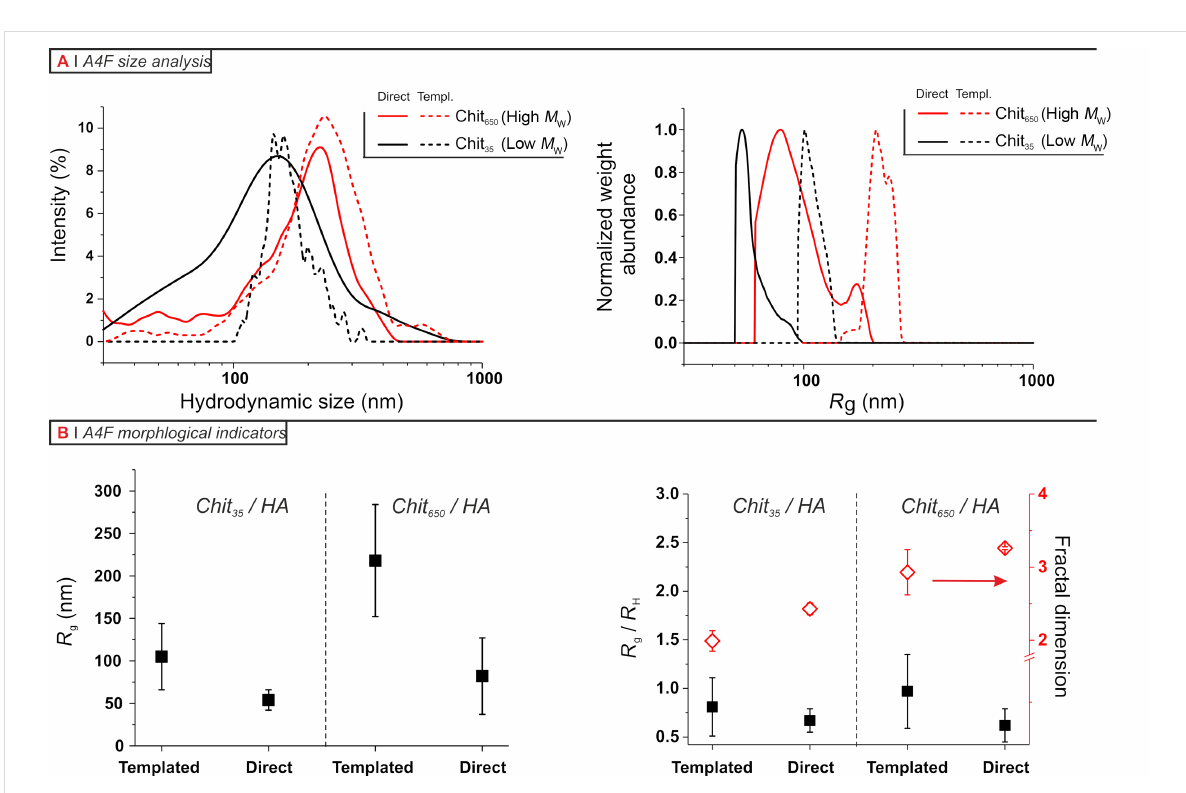
Figure 3: A) Asymmetric-flow field flow fractionation (AF4) characterization of nanoparticles (see also Supporting Information File 1, Figure S3 for ex- amples of AF4 elugrams). Left: hydrodynamic size distributions from in-line DLS. Right: R g distributions from in-line SLS. B) Morphological indicators obtained from AF4 analysis. Left: Weight-average R g values and Right: mass fractal dimension and R g / R h ratio for the four kinds of chitosan/HA nano- particles. Please note that the error bars in the first graph are the widths at half maximum of the log-normal fit of the differential R g distributions, in the second graph are the errors of the